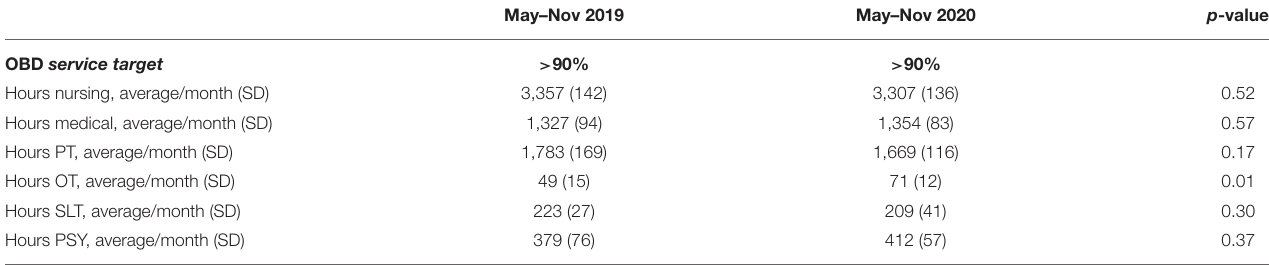
TABLE 2 | Volume of activity and staff capacity in the two